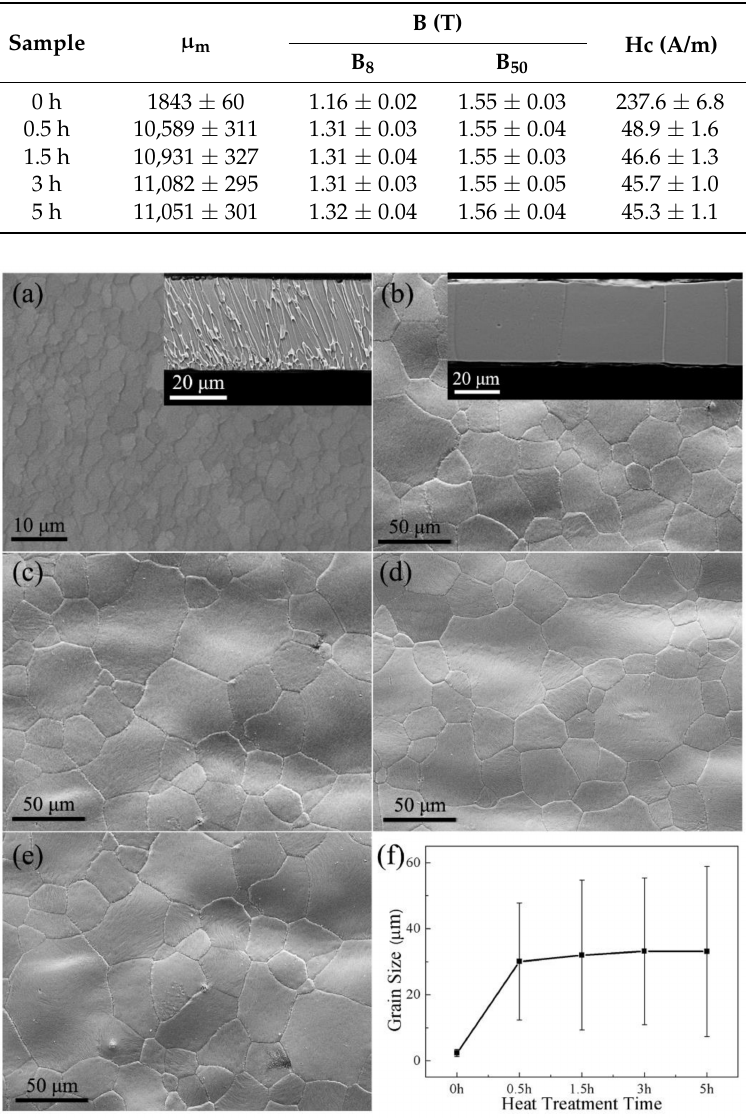
Figure 2. Free surface microstructure of Fe-6.5 wt. % Si ribbons ( a ) in the absence of heat treatment; ( b ) 1000 ◦ C, 0.5 h; ( c ) 1000 ◦ C, 1.5 h; ( d ) 1000 ◦ C, 3 h; ( e ) 1000 ◦ C, 5 h. ( f ) Grain size